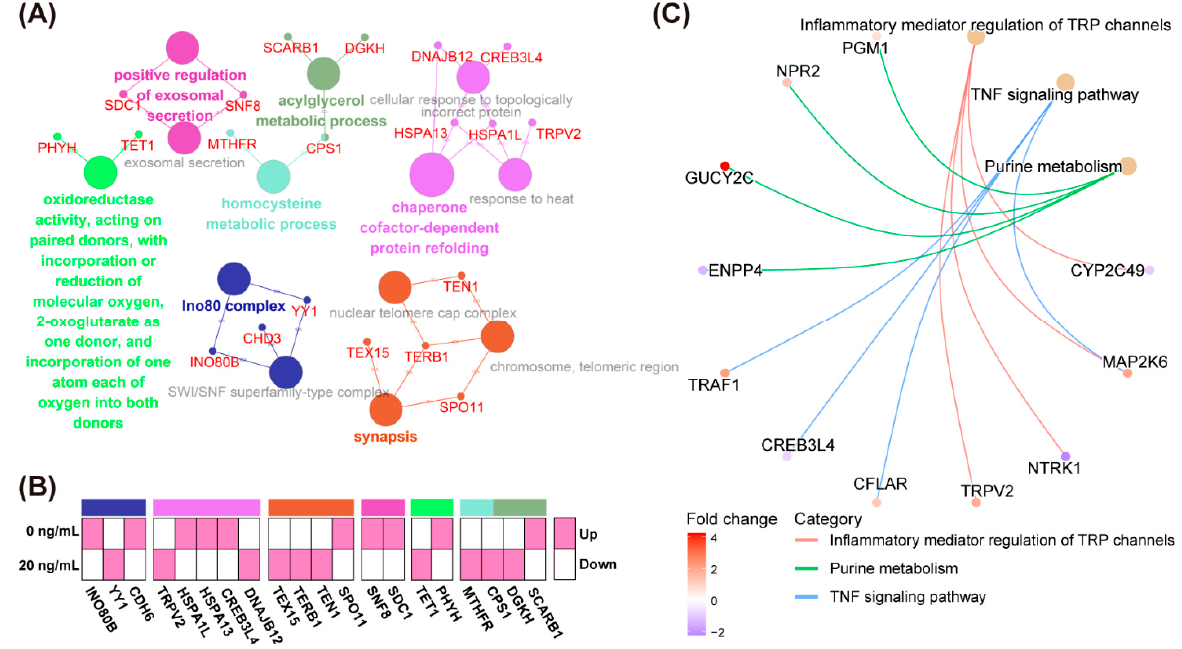
Figure 7. Functional enrichment analysis of DEGs between control and 20 ng/mL SDF1-treated groups. ( A ) The GO term enrichment analysis of DEGs. Different colors of nodes refer to the functional annotation of ontologies, the gray fonts represent non-significant terms, and the red fonts represent DEGs in significantly enriched GO terms. ( B ) The up-regulated and down-regulated DEGs in significantly enriched GO terms. ( C ) The KEGG term enrichment analysis of DEGs.